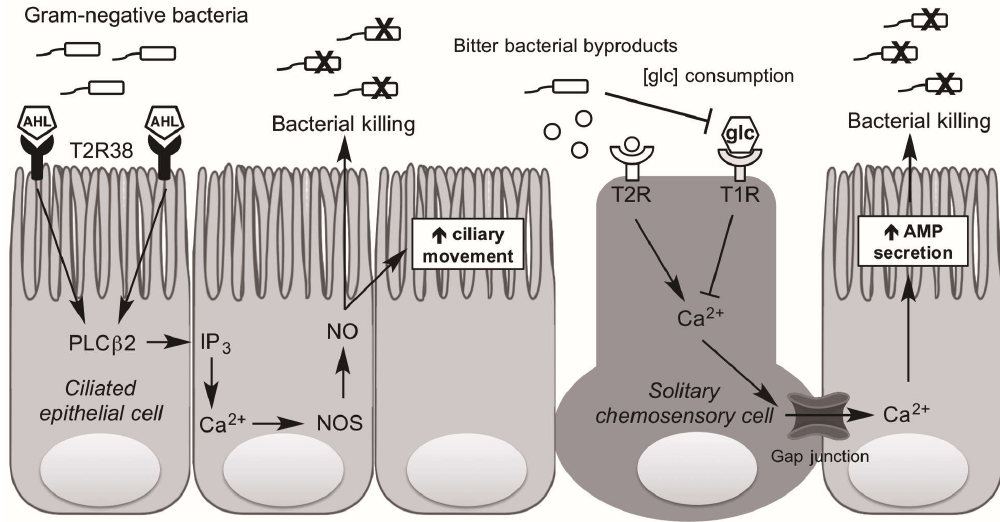
Figure 3. Taste receptor-dependent upper airway immunity. Ciliated epithelial cells express T2R38 while solitary chemosensory cells (SCCs) express both T2Rs and T1Rs. Gram-negative bacteria produce acyl-homoserine lactones (AHLs), which bind to and activate T2R38, producing an intracellular cascade activating PLC β 2 and production of IP 3 . This increases nitric oxide (NO) production through the activation of nitric oxide synthase (NOS), which both directly kills bacteria and enhances ciliary beating. Additionally, presumed other bitter bacterial byproducts activate an as yet unknown T2R(s) on solitary chemosensory cells and, through typical taste receptor intracellular signaling including gustducin, yields increased Ca 2+ . This Ca 2+ diffuses into adjacent ciliated cells via gap junctions where it produces increased antimicrobial peptide (AMP) secretion, killing pathogens. Due to glucose (glc) consumption by bacteria, microbial colonization also decreases the T1R-mediated inhibition of SCC Ca 2+ release, thereby contributing to enhanced antimicrobial peptide